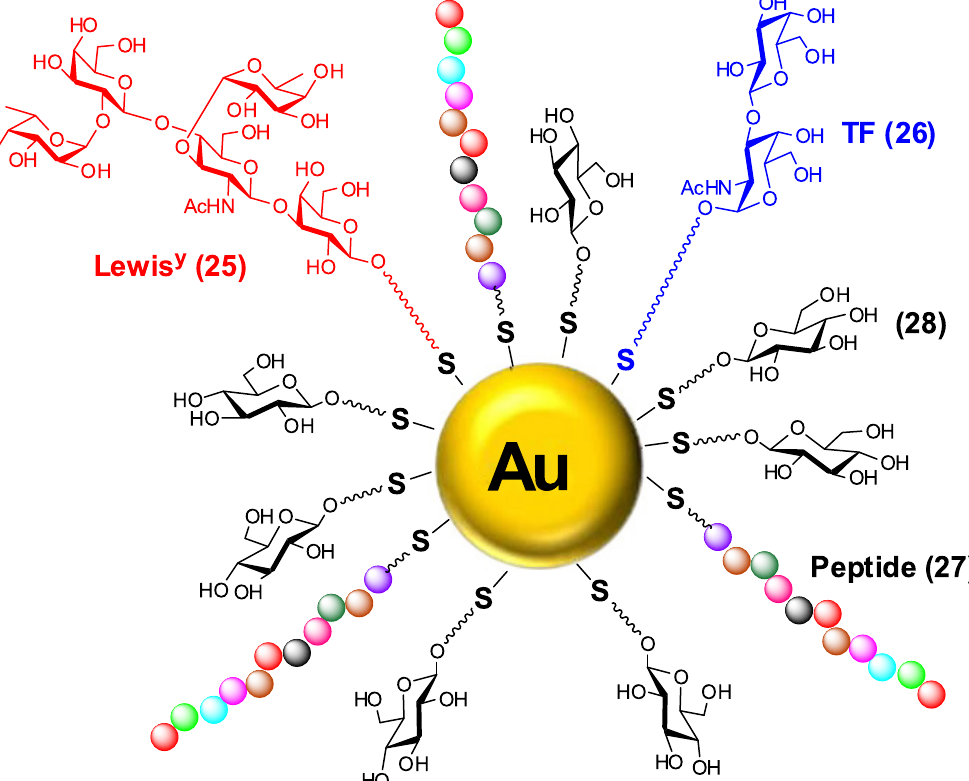
FIGURE 12 - Molecular structures of gold NPs based tumor vaccines exposing various sugar